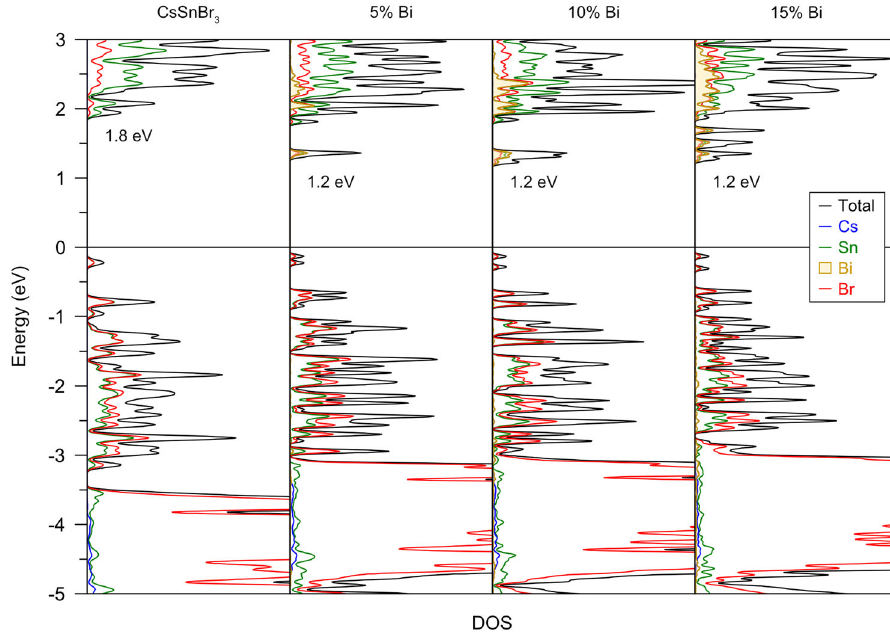
Fig. 5 Electronic property calculations. DOS curves for CsSnBr 3 and Bi-substituted models, from calculations using HSE06